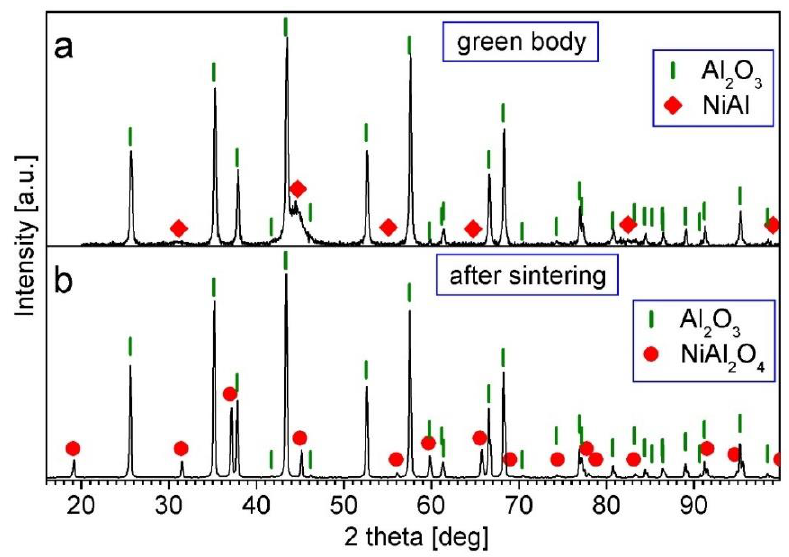
Figure 10. XRD patterns of the Al 2 O 3 + 5 vol.% of (NiAl + 30 wt.% A 2 O 3 ) sample: (a) green body; (b) after sintering at 1450 °C for 2 h.